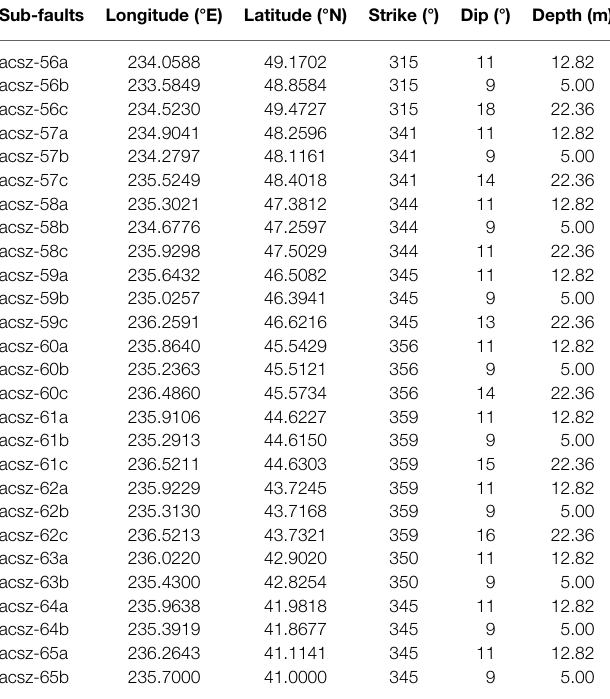
TABLE 1 | Geologic sub-faults information at Cascadia subduction